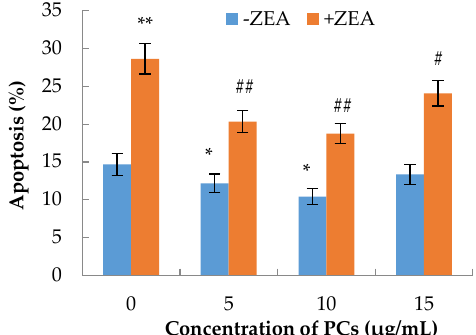
Figure 5. Effects of different concentrations of proanthocyanidins (PCs) on the apoptosis rates of MODE-K cells exposed to zearalenone (ZEA) (65 μmol/L). Rates of apoptosis increased when cells